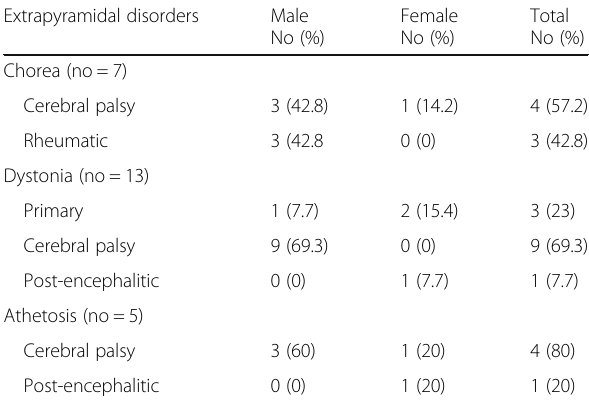
Table 2 Percent of dystonia, chorea, and athetosis among both sex in Al Quseir City,